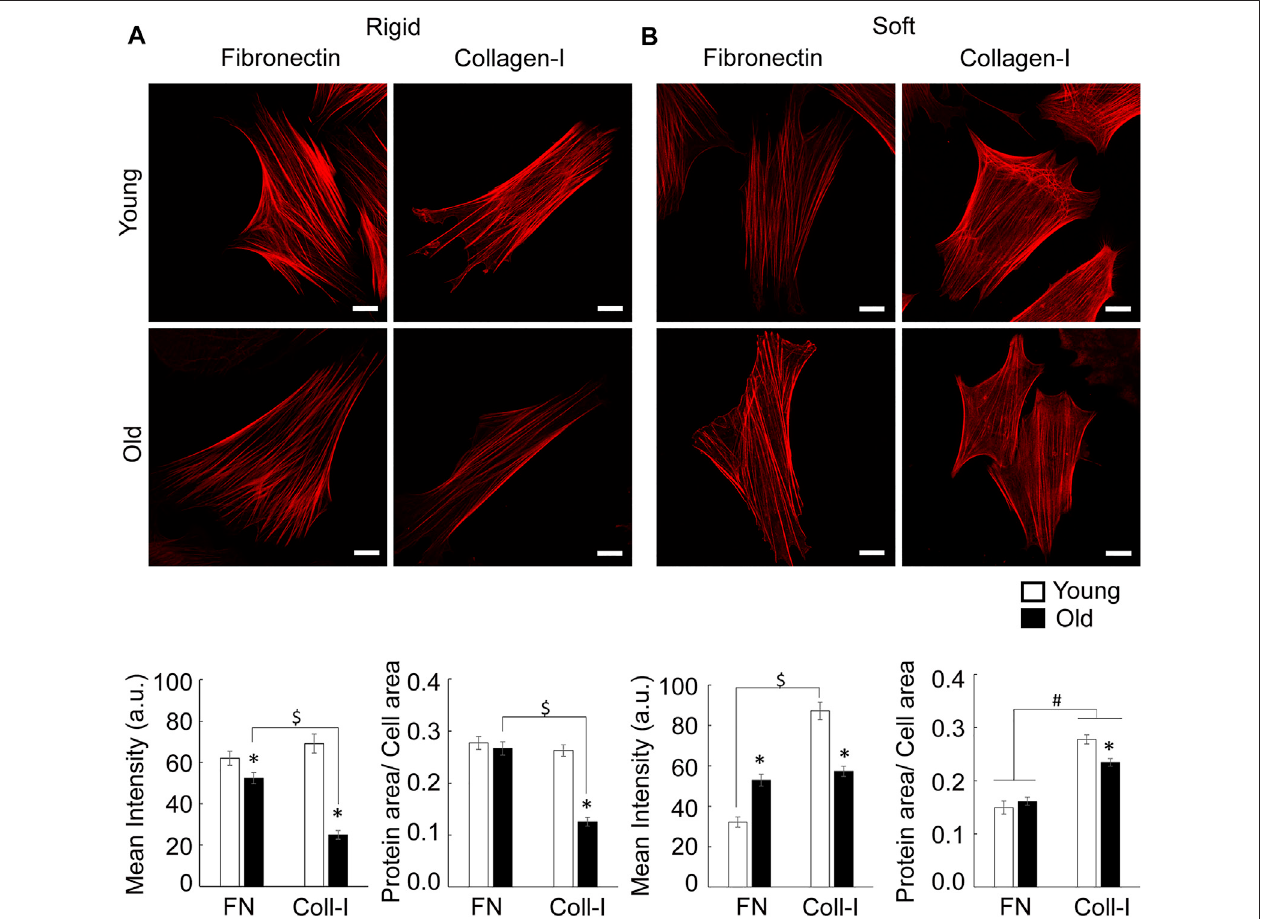
FIGURE8|(A) RepresentativeconfocalimagesofVSMcellsplatedonrigidsubstratesfunctionalizedwith fi bronectinorcollagen-Iareshown.VSMcellshavebeen fl uorescently labeled for SM α -actin. Scale bar represents 10 μ m. Quantitative measurements of overall fl uorescence intensity and actin fi ber segmentation ( n = 34 – 68) are presented as mean ± SE. Signi fi cance was evaluated at p < 0.05. (B) Representative confocal images of VSM cells plated on soft substrates functionalized with fi bronectin or collagen-I are shown. VSM cells have been fl uorescently labeled for SM α -actin. Scale bar represents 10 μ m. Quantitative measurements of overall fl uorescence intensity and actin fi ber segmentation ( n = 22 – 42) are presented as mean ± SE. Signi fi cance was evaluated at p < 0.05. *Values are signi fi cantly different from young. $ Values are signi fi cantly different from age matched VSM cells on different matrices. # Values are signi fi cantly different between